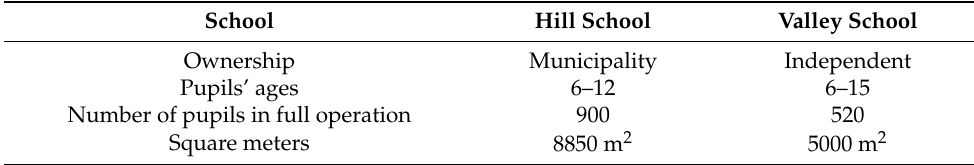
Table 1. Description of Hill School and Valley School.